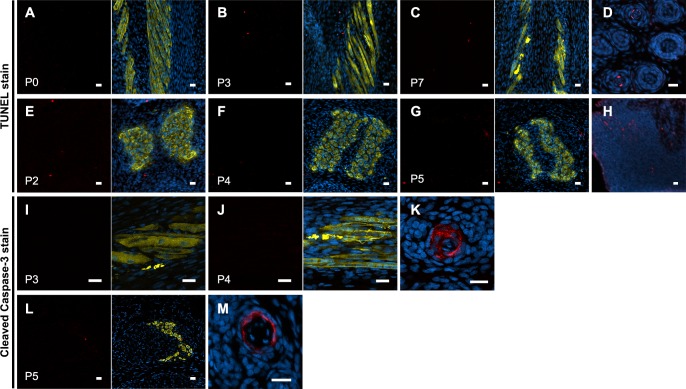
No evidence of jerboa foot muscle apoptosis.TUNEL staining (TUNEL and merge with DAPI and Myosin) for apoptotic nuclei in longitudinal and transverse sections of interosseous muscle in the (A) P0 (n = 1 animal), (B) P3 (n = 3), (C) P7 (n = 1), (E) P2 (n = 2), (F) P4 (n = 5), and (G) P5 jerboa foot (n = 3). (D) Apoptotic keratinocytes as positive control for A-C and (H) apoptotic limb bud cells as positive control for E-G. Cleaved Caspase-3 staining (Cleaved Caspase-3 and merge with DAPI and Myosin) for apoptotic nuclei in longitudinal and transverse sections of interosseous muscle in the (I) P3 (n = 1 animal), (J) P4 (n = 5), (L) P5 jerboa foot (n = 2). (K) Apoptotic kerotinocytes as positive control for I-J and in (M) for L. Scale bars are each 20 µm.